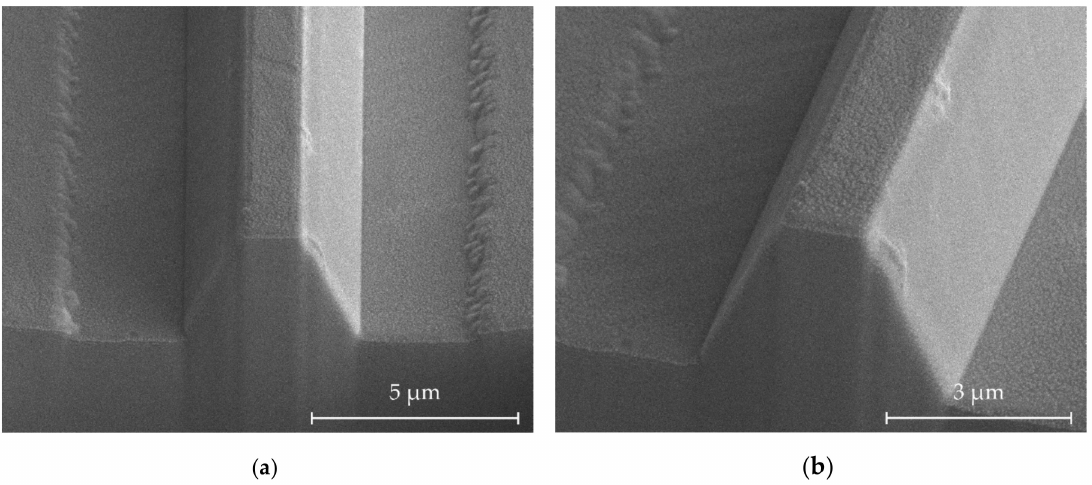
Figure 8. Ridge structures after redeposition stripping. The feature width at the top is 1.4 µ m, the etch depth is 3.1 µ m, the width at the bottom is 4.2 µ m, and the sidewall angle is 67 ◦ . ( a ) Normal view, ( b ) 15 ◦ rotated view of the same structure, showing low sidewall